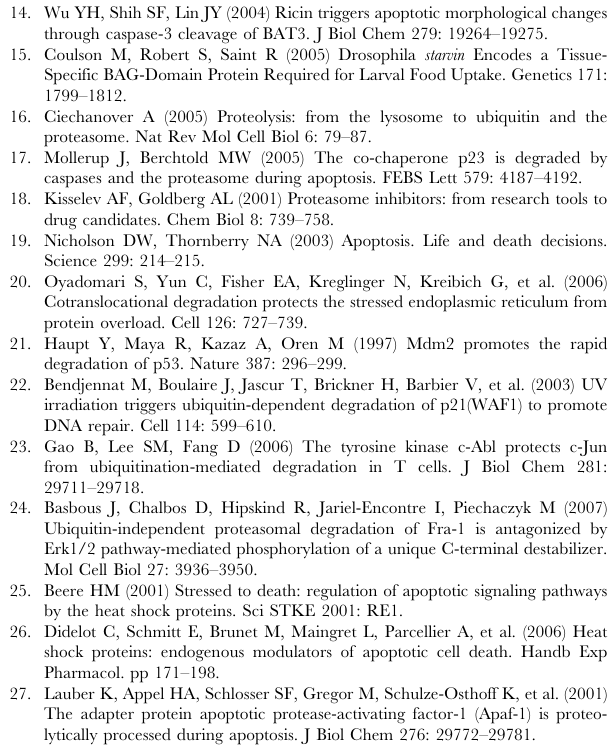
groups were made by unpaired Student’s t -test using GraphPad Prism software (San Diego, CA). Two-sided p values are reported. Figure S1 A fraction of BAG3 co-localizes with mitochondria in early STS-mediated stress. BAG3 stained cells (green) loaded with Mito Tracker (red) and counterstained with DAPI (blue). Arrows show colocalization in yellow. At higher STS doses, there is loss of the BAG3 green signal and a generalized uptake of Mito Tracker in cell nuclei (arrow head) indicating loss of both nuclear and mitochondrial membrane integrity. Figure S2 BAG3 is transiently induced in early STS-mediated stress. A. Flow cytometry of MDA435 cells stained for BAG3 (secondary Alexa 666 anti Rabbit) and subject to increasing STS doses. B. MDA435 cells stained for BAG3 after 4 h STS exposure (secondary Alexa 594 anti Rabbit). Figure S3 Inhibition of caspases and proteasome provides collaborative protection of BAG3. A. Proteasome inhibition with lactacystyin (1 m M, 4 hr preincubation) in MDA-435 cells overexpressing BAG3 or BAG3-dPXXP provides partial protec- tion of BAG3. B. Lactacystin in combination with zVAD provides near full protection of BAG3, similar to MG-132. Found at: doi:10.1371/journal.pone.0005136.s003 (0.29 MB TIF)